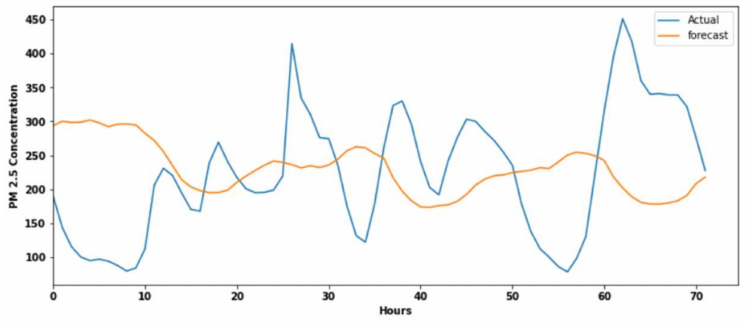
Figure 11. Forecasting for the next 72 h for Lahore using the multivariate FbProphet model.